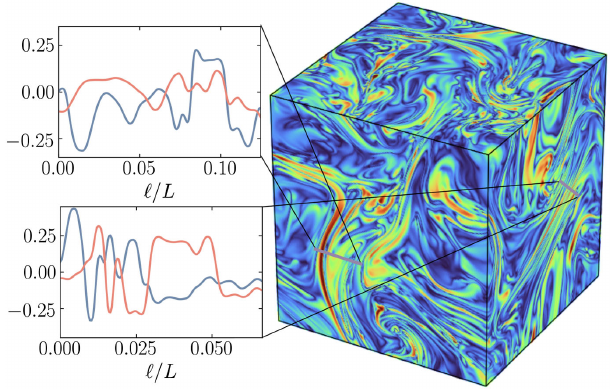
FIG. 3. Snapshot of magnetic-field strength in the saturated state of run c7 ( 1120 3 , Pm ¼ 500 , Re ≈ 20 , Rm ≈ 10 4 ). Large Pm results in elongated laminar current sheets, in contrast to those seen in run c2 [ 1120 3 , Pm ¼ 10 , Re ≈ 10 3 , Rm ≈ 10 4 ; see Fig. 2(a)]. Two 1D spatial cuts of the magnetic field are shown on the left side; colors indicate different projections of the magnetic field: in plane (blue) and out of plane